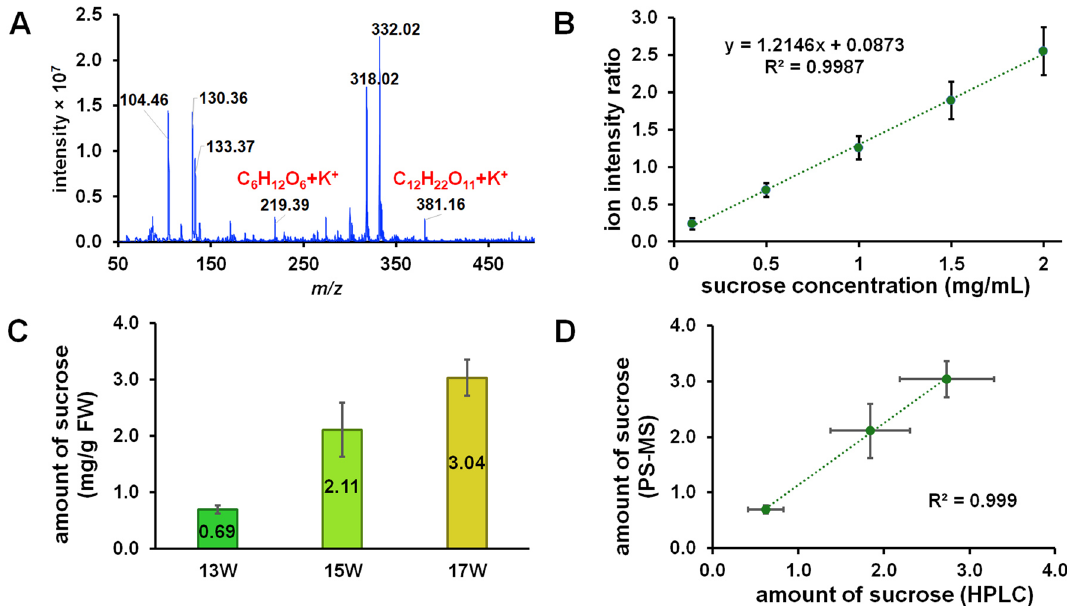
Figure 4. ( A ) Full-scan mass spectrum of liquid extract by PS-MS; ( B ) Calibration plots between the ratio of the intensities of the product ion from sucrose ( m/z 203) over that from sucrose- d 2 ( m/z 205); ( C ) the amounts of sucrose from durian peduncles at 3 different maturities analyzed by PS-MS; and ( D ) a scattered plot showing the correlation between determined amount of sucrose from HPLC and PS-MS